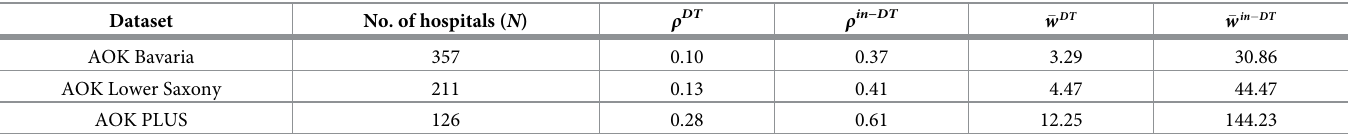
Table 2. Basic description of AOK hospital networks. Dataset